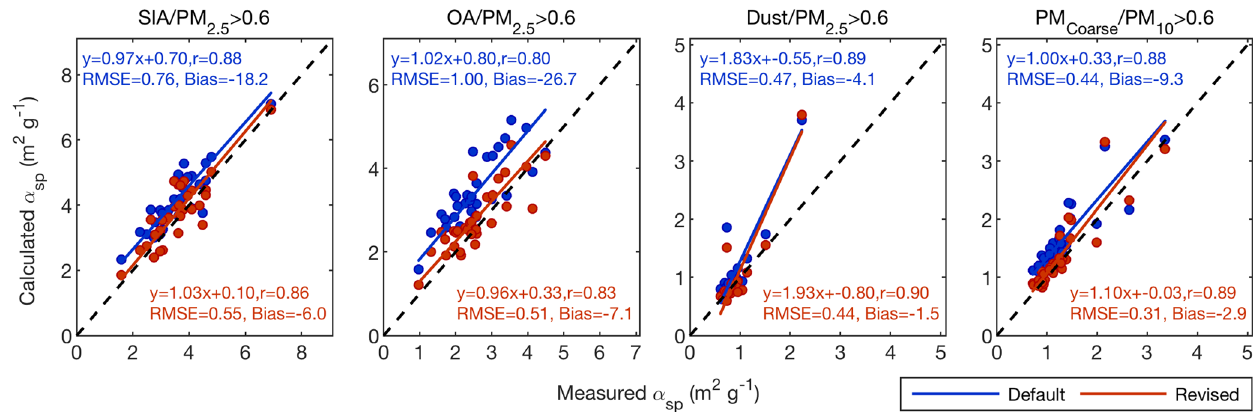
Figure 4. Average measured vs. calculated α sp (550nm) at IMPROVE sites between 2000 and 2010 using GEOS-Chem default and revised optical tables for measurements taken in conditions dominated by secondary inorganic aerosols (SIA), organic aerosols (OA), fine dust, and PM coarse (PM 10 –PM 2 . 5 ). The 1 : 1 line is black. Slope, offset, and correlation coefficient are inset.